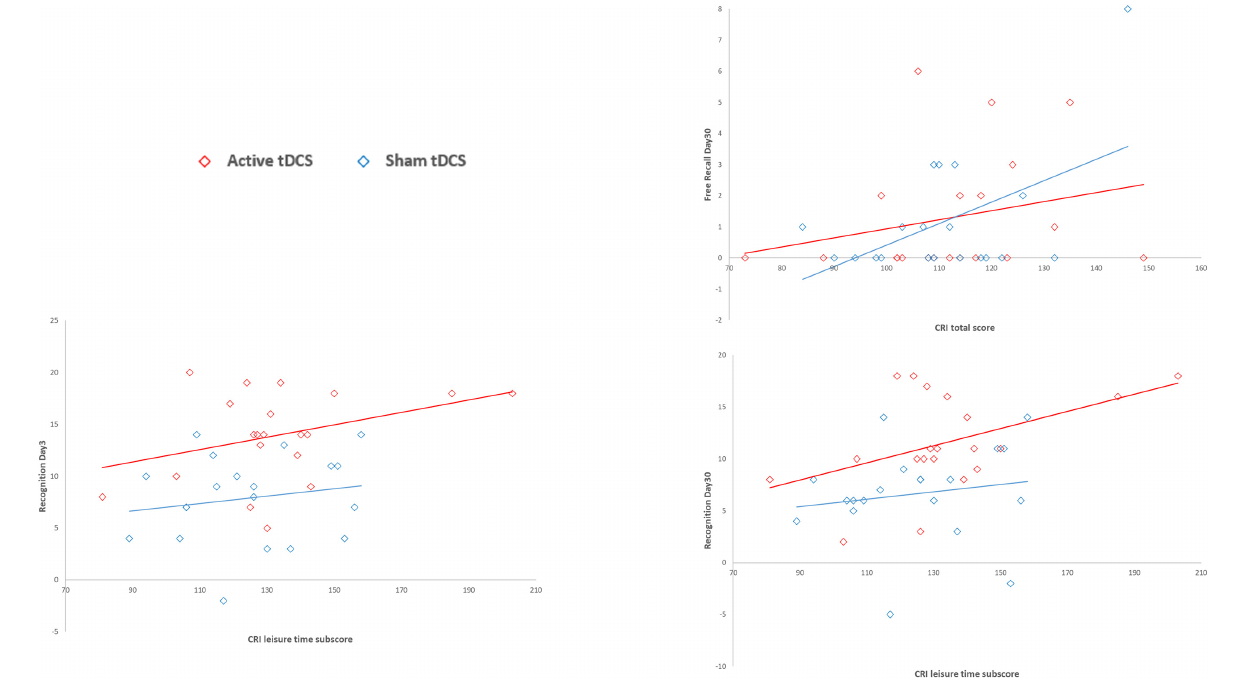
the predictors on response variables was apparent irrespective of tDCS treatment (sham or active) group (see Figure 3 ). Similar